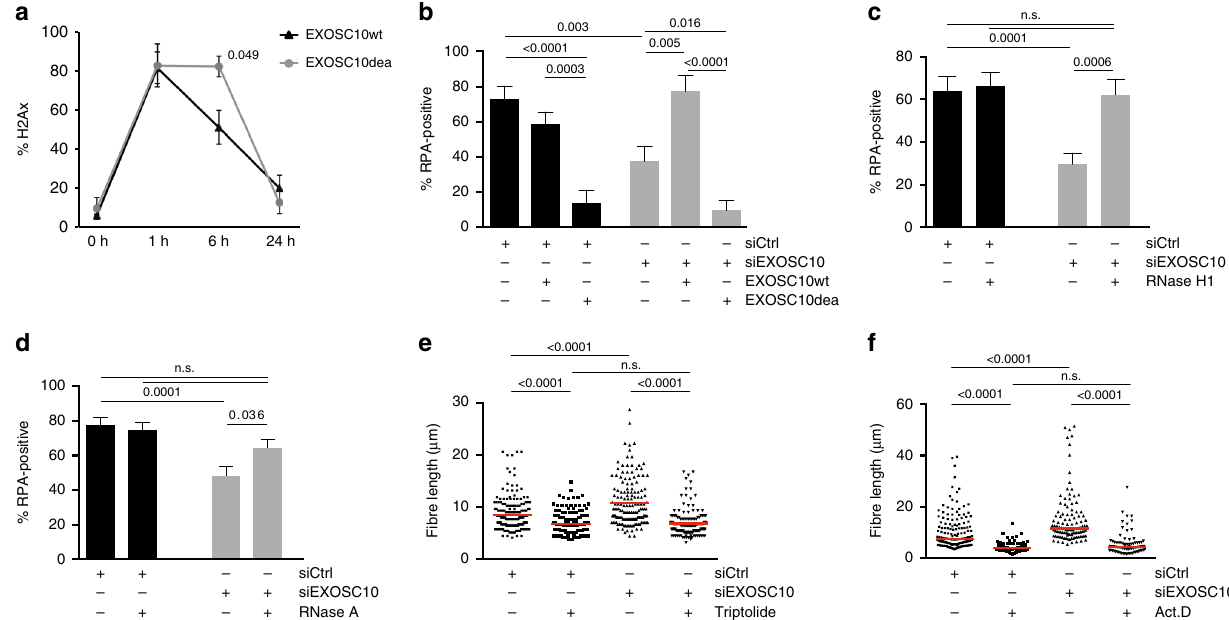
Fig. 6 DilncRNA degradation is necessary for RPA recruitment. a The EXOSC10 catalytically inactive mutant EXOSC10 dea or wild-type EXOSC10 were overexpressed in HeLa cells and γ H2AX immuno fl uorescence was performed at 0, 1, 6, and 24 h after exposing the cells to γ -radiation (5 Gy). The graph shows the percentage of cells with γ H2AX foci ( n = 150 cells analysed at each time point, from three different experiments). b HeLa cells were transfected with either siCtrl or siEXOSC10. A second transfection was carried out 24 h later with plasmids for expression of EXOSC10 wt or EXOSC10 dea , as indicated. The cells were micro-irradiated with a 365 nm UV laser 24 h after the second transfection and the recruitment of RPA to the laser stripes was analysed as in Fig. 2b ( n > 20 cells for each condition, from three independent experiments). c HeLa cells were transfected with either siCtrl or siEXOSC10. A second transfection was carried out 24 h later with a plasmid for expression of RNase H1 and the recruitment of RPA to laser stripes was analysed ( n = 50 cells analysed in each condition, from three independent experiments). d HeLa cells transfected with either siCtrl or siEXOSC10 were micro-irradiated with a 365 nm UV laser, permeabilized with CSKT and treated with or without RNAse A for 30 min at 37 °C. The graph shows the percentage of cells with γ H2AX stripes that were co-stained with RPA ( n > 80 cells analysed in each condition, from three independent experiments). e , f SMART was done in U2OS cells transfected with either siCtrl or siEXOSC10. The cells were treated with 10 µ M Triptolide for 30 min ( e ) or 8 µ M ActD for 1 h ( f ) before exposure to γ -radiation (10 Gy). The plot shows the measurements of fi bre length from one representative experiment ( n = 200 analysed fi bres). The averages of the median values from three independent experiments are shown in Supplementary Fig. 9. In all cases, the error bars represent s.e.m. and p -values were calculated with Mann – Whitney ’ s test. Source data for Fig. 6a – f are provided as a Source Data fi